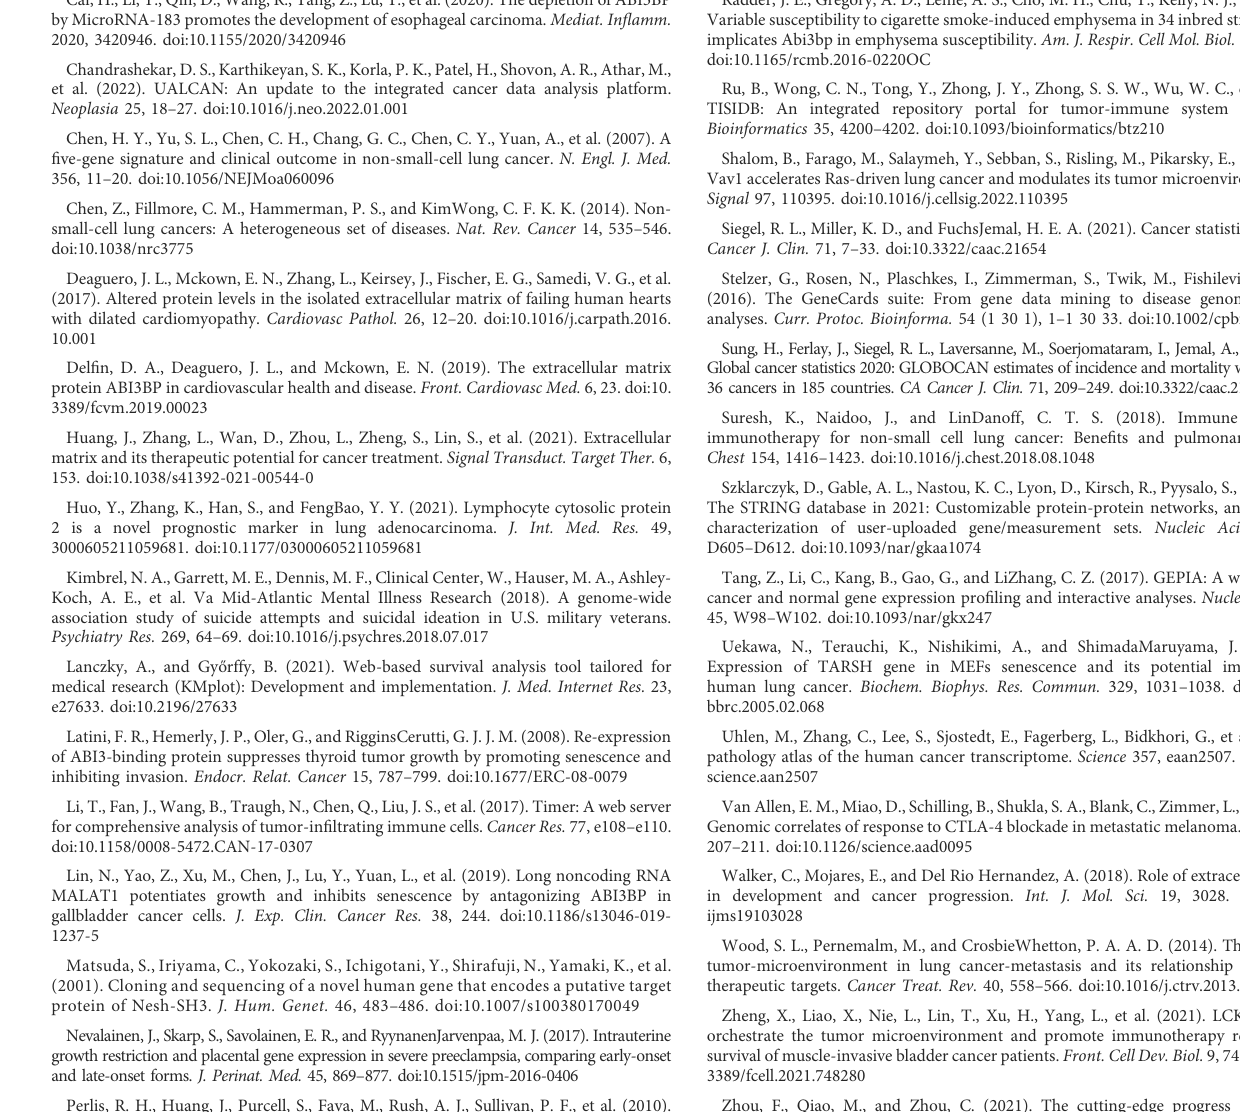
SUPPLEMENTARY FIGURE S2 The protein network of the ABI3BP-related genes and the mutation of the hub genes. (A) A network of 544 proteins in LUAD that are functionally similar to ABI3BP. (B) LUSCproteinnetworkof563functionallysimilargenestoABI3BP. (C) SNV mutation frequency of hub genes in LUSC. (D) Oncoplot provides the situation of the SNV of the hub genes. SUPPLEMENTARY FIGURE S3 Relationship between ABI3BP and immunoin fi ltrationinLUSC. (A) TMEscore of ABI3BP in LUSC. CIBERSORT (B) , XCELL (C) , QUANTISEQ (D) , MCPCOUNTER (E) , and EPIC (F) analysis between ABI3BP and tumor immune cells in LUSC. SUPPLEMENTARY FIGURE S4 Relation of ABI3BP level of expression and lymphocyte, immunity modulator and chemokine in LUSC on the basis of TISIDB repository. (A) Relation of the abundance of tumor-in fi ltrating lymphocytes (TIL) and ABI3BP (6 TILwith the greatest correlation); (B – D) Relation of immunomodulators and ABI3BP (6 immunomodulators with the greatest correlation); (E,F) Relation of chemokines (or receptors) and ABI3BP (6 chemokines (or receptors) with the greatest